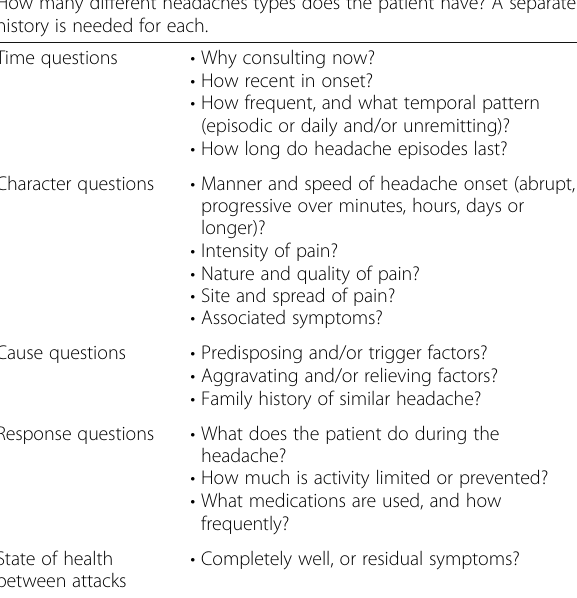
Table 4 Diagnostic questions to ask in the history How many different headaches types does the patient have? A separate history is needed for